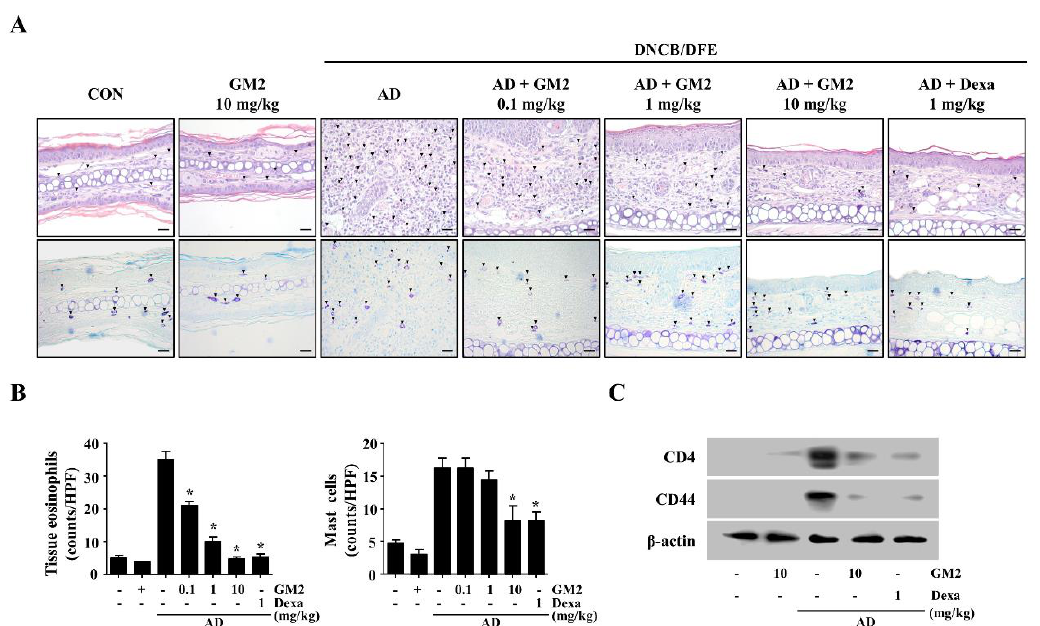
Figure 3. Effect of GM2 on the infiltration of the inflammatory cells in AD-like skin lesions. Representative ear tissue samples from the DNCB/DFE-induced mouse model. ( A ) The infiltration of tissue eosinophils is detected by H&E stain (upper panel, black triangle) and infiltration of the mast cells is detected by TB stain (down panel, black triangle). All scale bar = 20 µ m. magnification 400 × . ( B ) The number of tissue eosinophils and mast cells is expressed as the mean number of cells at five random sites on each slide. Data are presented in the graph are the means ± SEM ( n = 5). * p < 0.05, compared with the DNCB/DFE-induced group. ( C ) Inhibition of CD4 and CD44 proteins in DNCB/DFE-induced mice ear tissue was analyzed by Western blot analysis. The loading control was confirmed using β -actin in independent blots from three randomly selected ear tissue per each group. Dexa: dexamethasone.